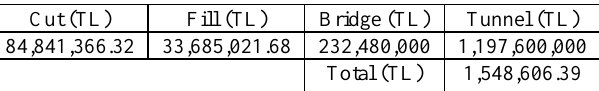
Table 22. Approximate total cost of constructing an alternative line on mountainous